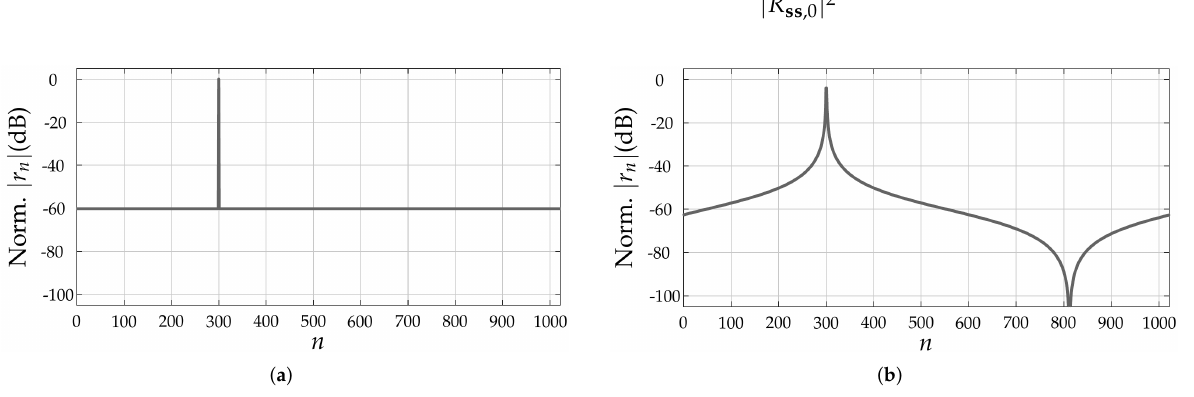
Figure 2. Non-oversampled range profiles obtained in a SISO-PMCW radar system adopting an m- sequence of length N PRBS = 1023: ( a ) target at range bin n = 300 and ( b ) target at range bin n = 300.5.